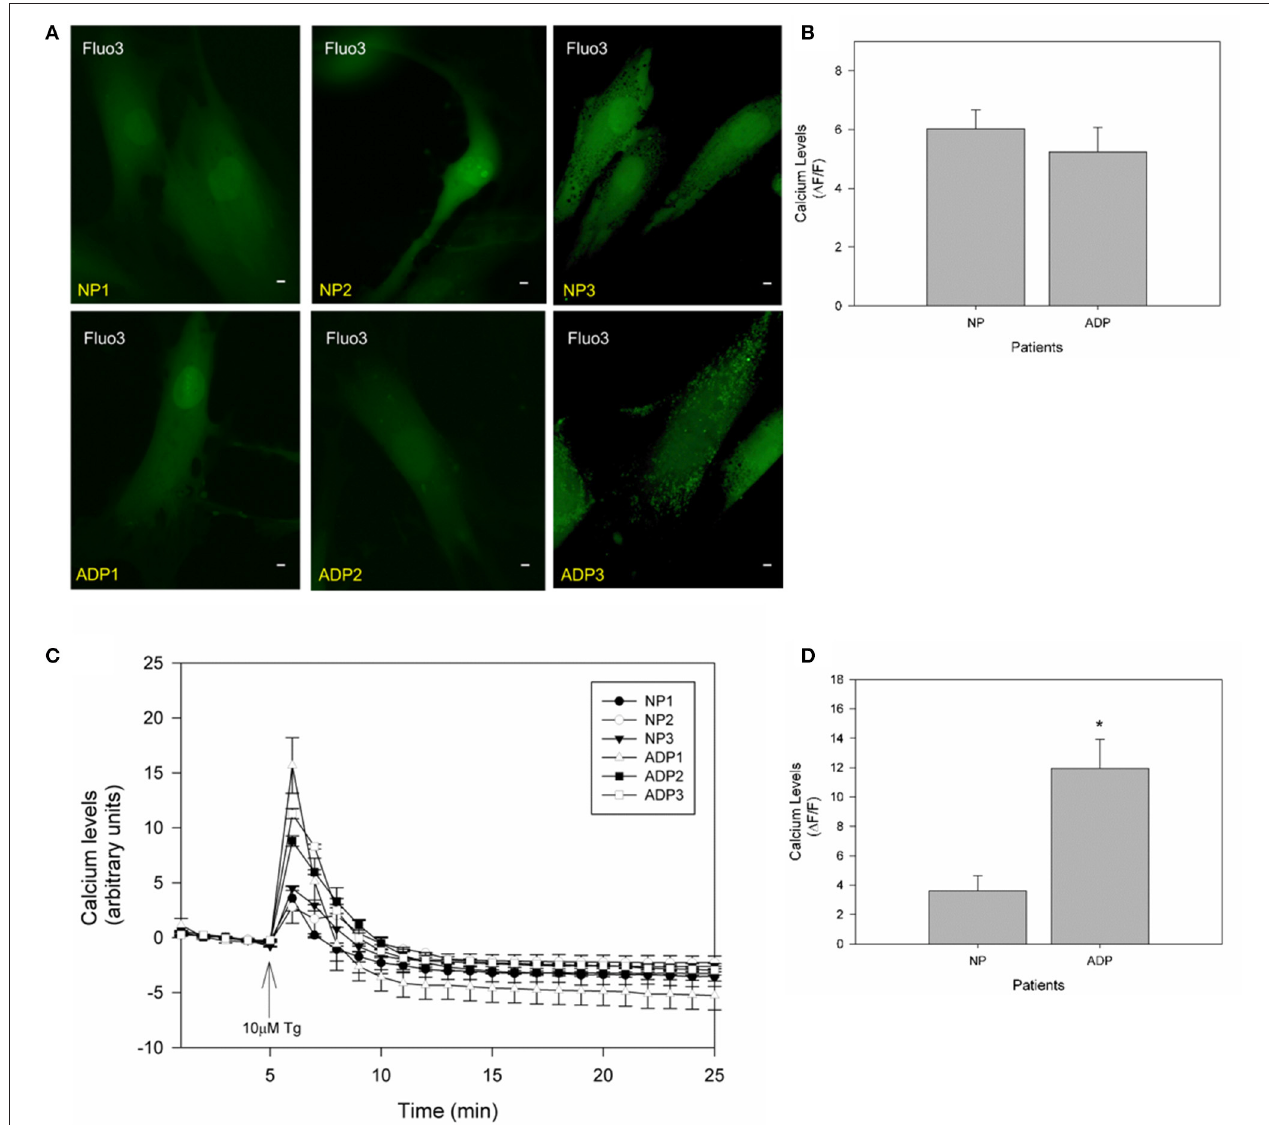
FIGURE 4 | Thapsigargin induces cytosolic calcium handling defects in AD fibroblasts. (A) Representative images of Fluo3 intensity showing relative basal cytosolic calcium levels in fibroblasts of control and AD patients. Bar = 10 µ m. (B) Quantification of relative cytosolic calcium levels as arbitrary units. Data are mean ± SE, n = 3 (technical replicates for each subject). (C) Representative trends of cytosolic calcium levels over 25min in AD and control fibroblasts. After 5min the cells were treated with 10 µ M of thapsigargin (arrow). Data are mean ± SE, n = 3 (technical replicates for each subject). ( D) Relative cytosolic calcium levels 1min after treatment with thapsigargin (peak of calcium increase). Data are mean ± SE. * p < 0.05 indicated differences between groups calculated by Student t